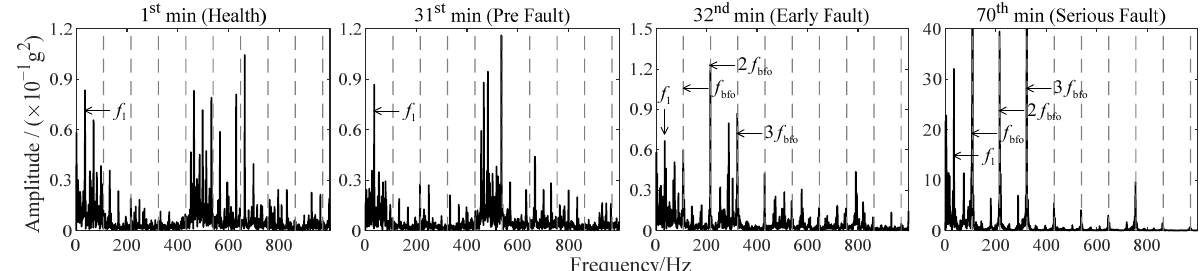
Figure 6. Fourier spectra obtained with improved TKEO for vibration signals in Figure 5b.